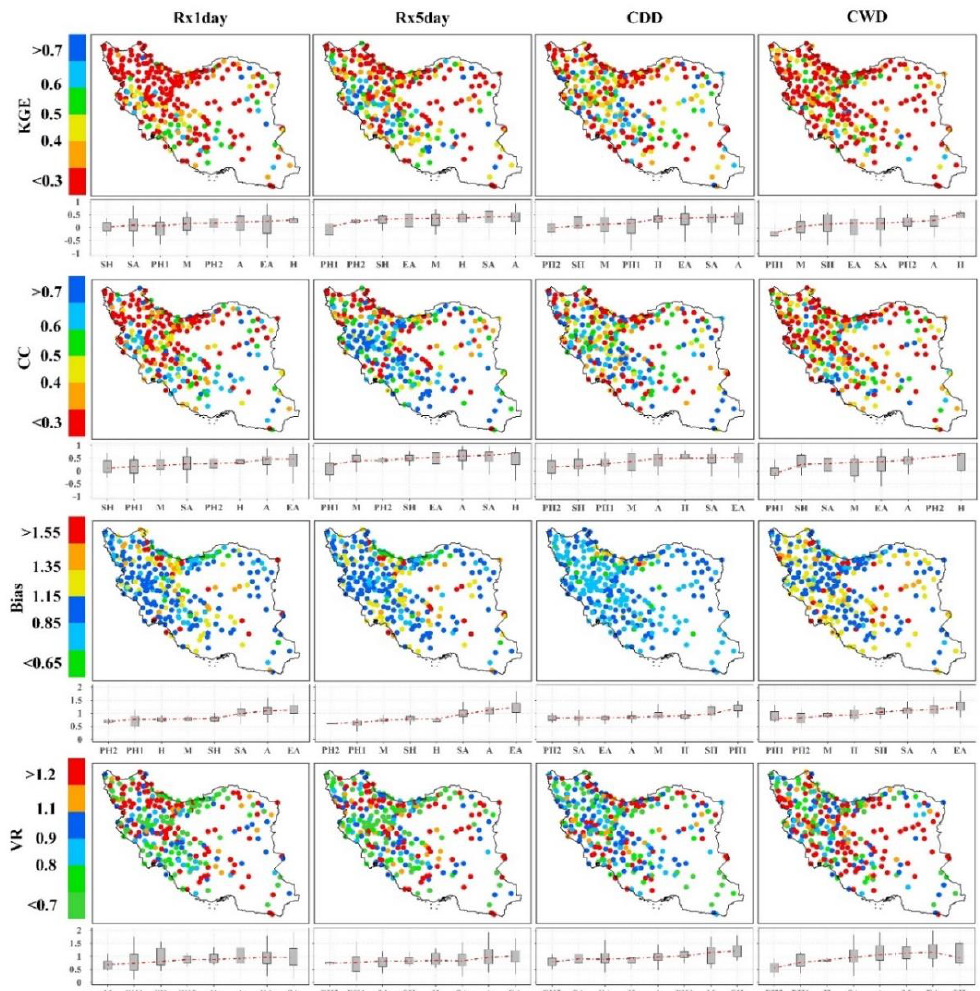
Figure 2. Reliability of GPM-IMERGV6.0 Final Run (GPM-IMERGF) in capturing maximum precipi- tation indices based on bias, correlation coefficient (CC), variability ratio, and Kling-Gupta efficiency (KGE) error